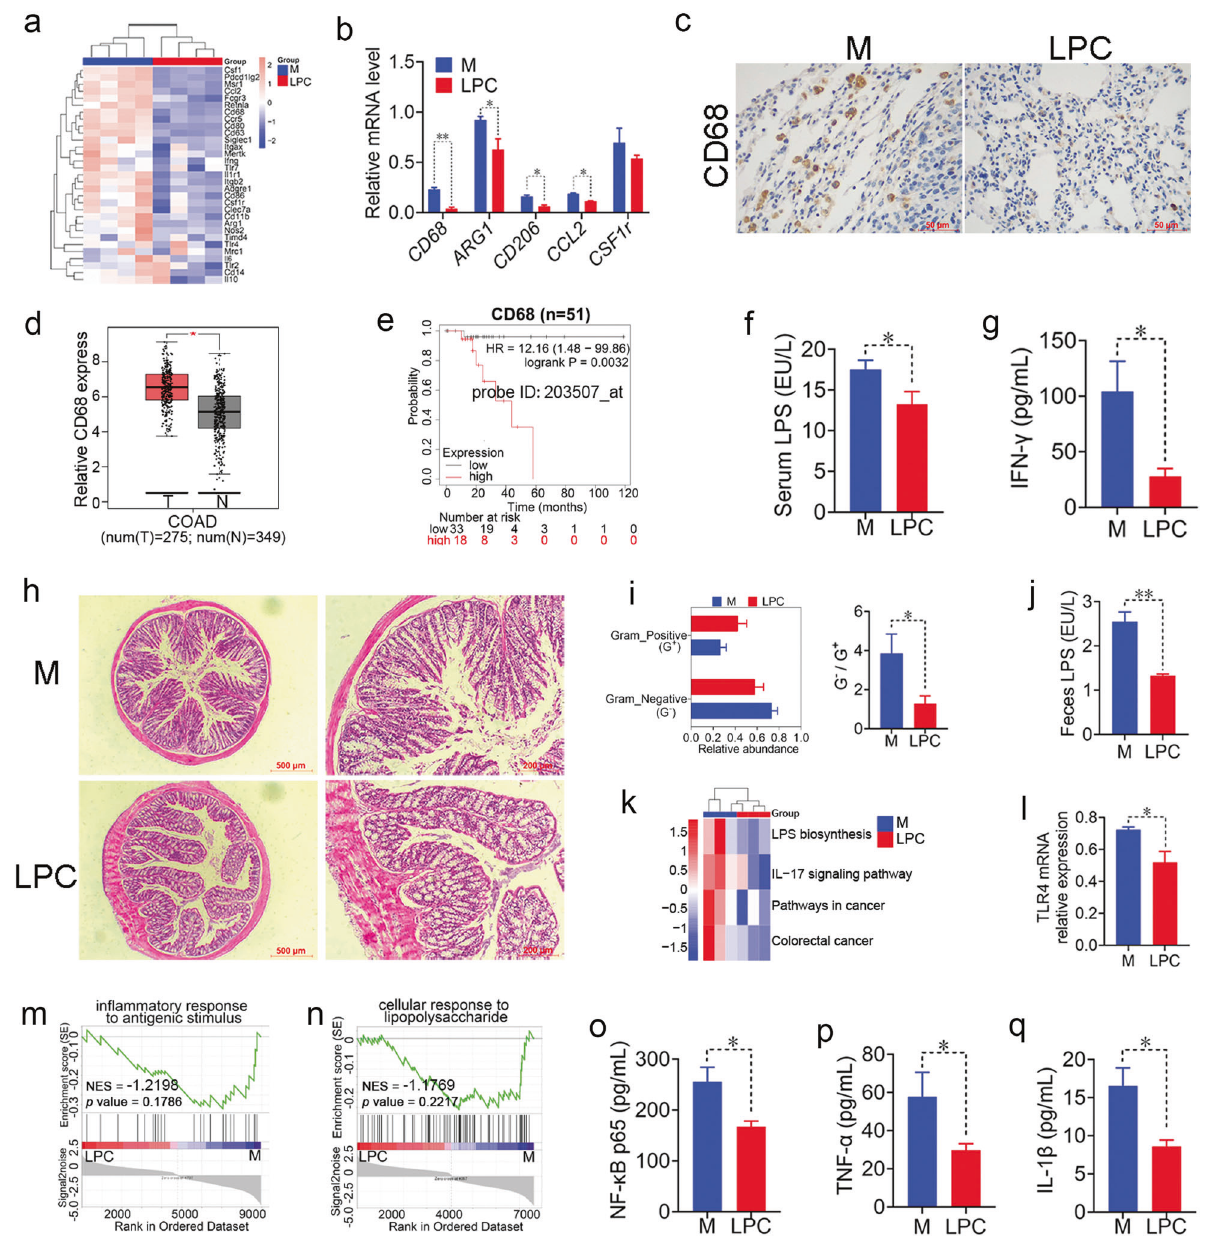
Fig. 4 LPC inhibits TAMs and in fl ammatory factor accumulation in pulmonary metastatic mice. a Heat map representing macrophage related genes pro fi le. b The gene expression of macrophage markers such as CD68, ARG1, CD206, CCL2 and CSF1R in lungs ( n = 3 mice). c The protein expression of CD68 in lungs. d Expression of CD68 gene pro fi le in colon cancer patients. e Kaplan-Meier curves of the relationship between gene expression of CD68 and survival probability in advanced colorectal cancer patients. f , g The serum levels of LPS and IFN- γ ( n = 3 and 6 mice). h Histomorphology of the colon. i The proportion of G − and G + microbes within microbiomes of stools, as predicted by BugBase ( n = 4 mice). j The level of fecal LPS ( n = 5 mice). k Functional pro fi ling of microbiome throughout disease progression. l mRNA expression of TLR4 in colon tissue ( n = 3 mice). m GSEA based on in fl ammatory response to antigen stimulates. n GSEA based on cellular response to lipopolysaccharide. o – q The serum levels of NF- κ B p65, TNF- α and IL-1 β ( n = 4 mice). Data were presented as mean ± SEM, * p < 0.05, ** p <